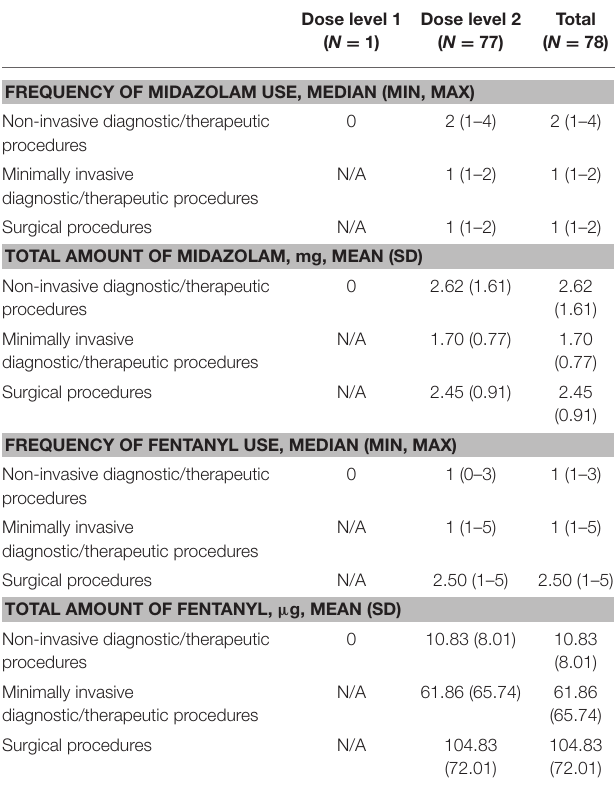
TABLE 5 | Summary of rescue therapy (efficacy evaluable population for rescued